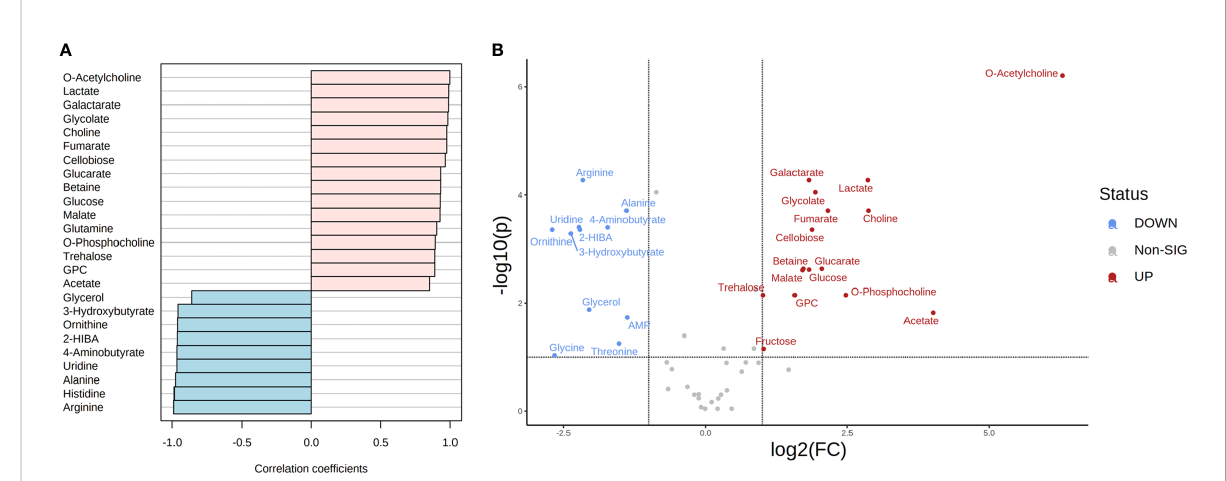
FIGURE 4 Metabolite correlation and signi fi cant differences in the metabolome of T. reesei and A. niger grown on CMC for 48 h. (A) List of the top 25 metabolites with higher correlation patterns in T. reesei (pink) and A. niger (blue). All metabolite correlation coef fi cients shown were signi fi cant (Pearson correlation > 0.7 and FDR < 0.1). (B) Volcano plot of metabolites with signi fi cant difference between both fungi. Metabolite levels were increased (red) or reduced (blue) in T. reesei compared to A. niger . 2-HIBA, 2-hydroxyisobutyrate; AMP, adenosine monophosphate; GPC, sn-